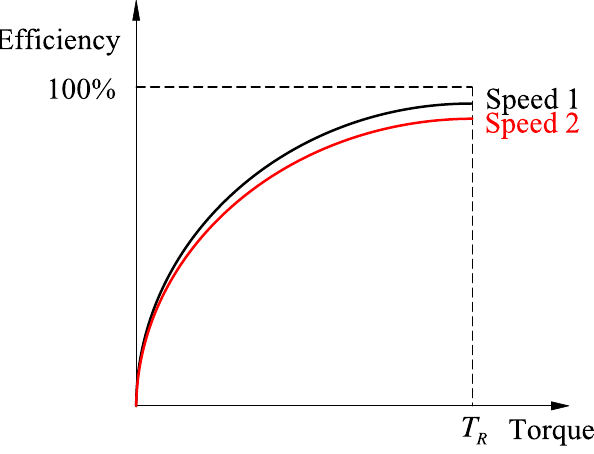
Fig. 1. Ef fi ciency – torque curve.